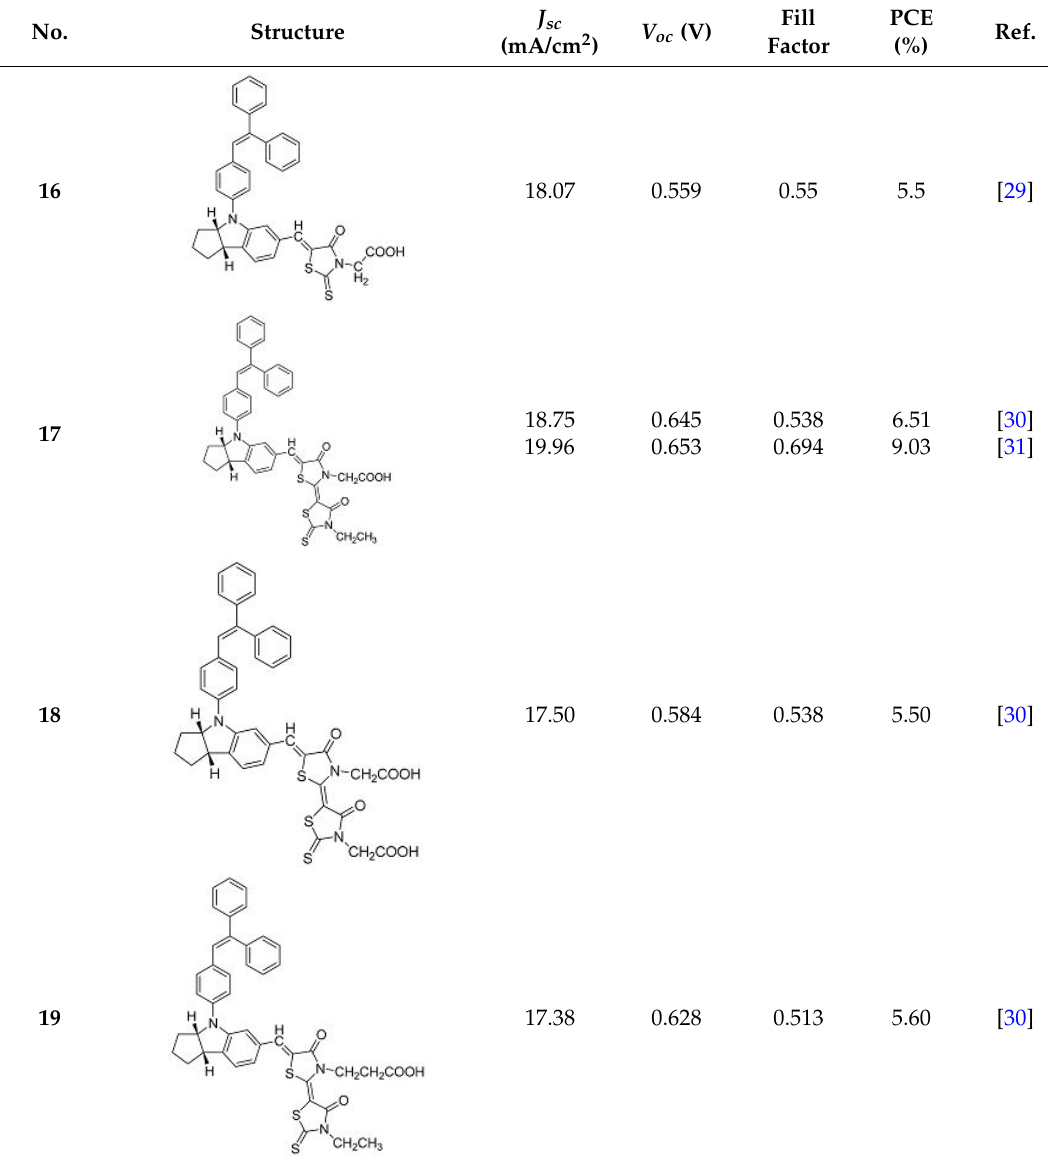
Table 2. Examples of metal-free DSSC dyes containing rotor structures. All examples below utilize liquid (I − /I 3 − ) electrolyte